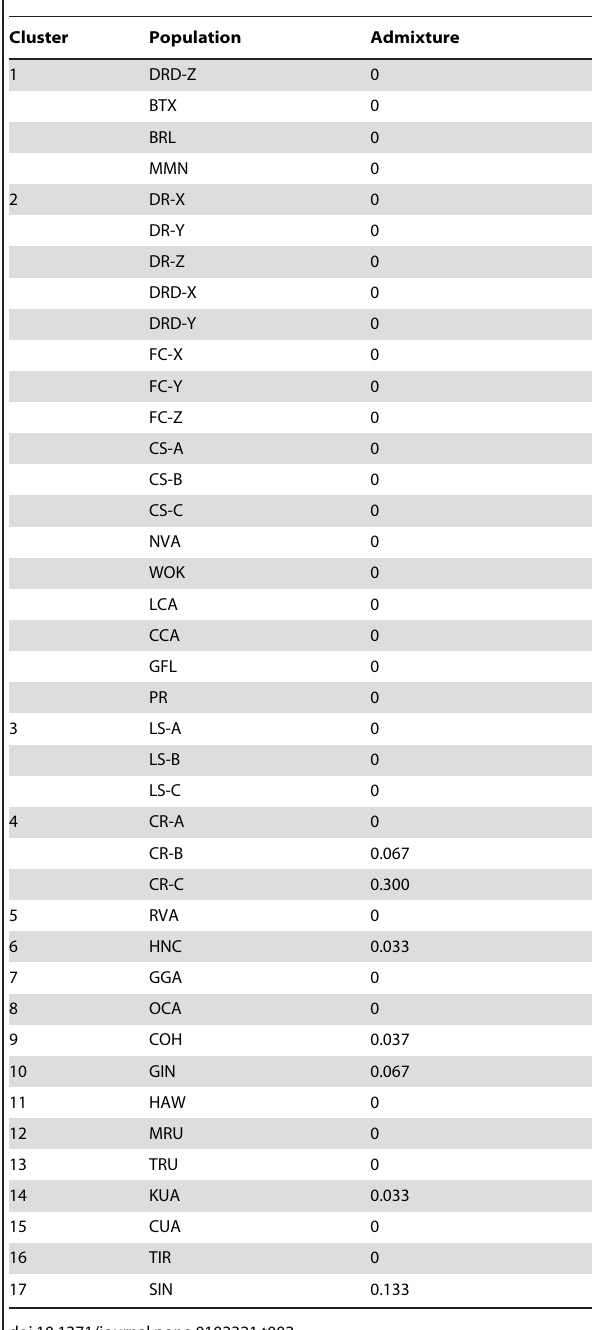
Table 2. Results from the Bayesian admixture analysis showing the grouping of populations into clusters and the proportion of significantly admixed individuals ( P , 0.05) in each